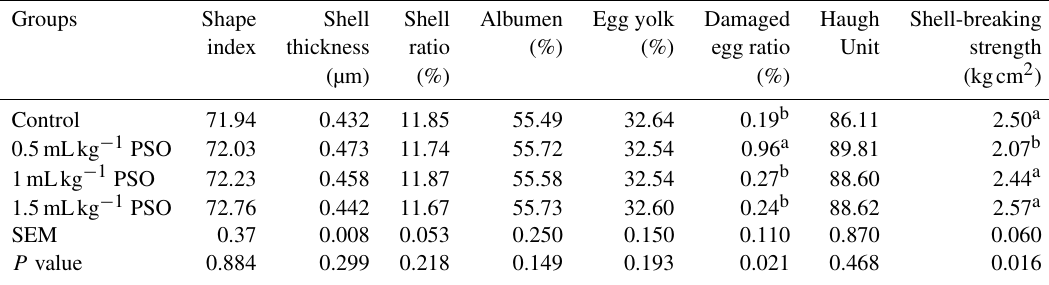
Table 4. Effect of pomagranate seed oil on egg quality in laying hens. Groups Shape Shell Shell Albumen Egg yolk Damaged Haugh Shell-breaking index thickness ratio (%) (%) egg ratio Unit strength (µm) (%) (%) (kgcm 2 )